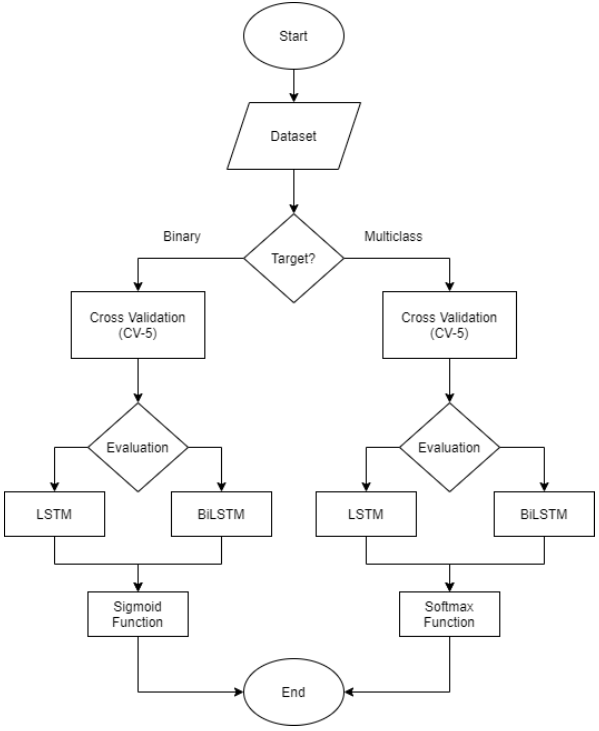
Figure 2. The evaluation procedure. Table 2. LSTM and BiLSTM hyper-parameter for binary dan multiclass